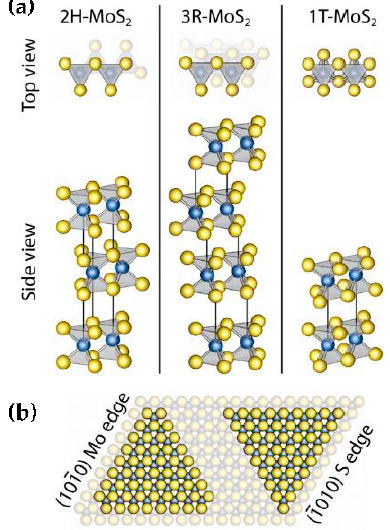
Figure 4. Figure showing the structures of MoS 2 . ( a ) Illustration of the layer packing in the three polytypes: 2H, 3R and 1T. ( b ) Top view of MoS 2 . Reprinted with permission from [89]. Copyright 2014 polytypes: 2H, 3R and 1T; ( b ) Top view of MoS 2 . Reprinted with permission from [89]. Copyright 2014 American Chemical Society. American Chemical